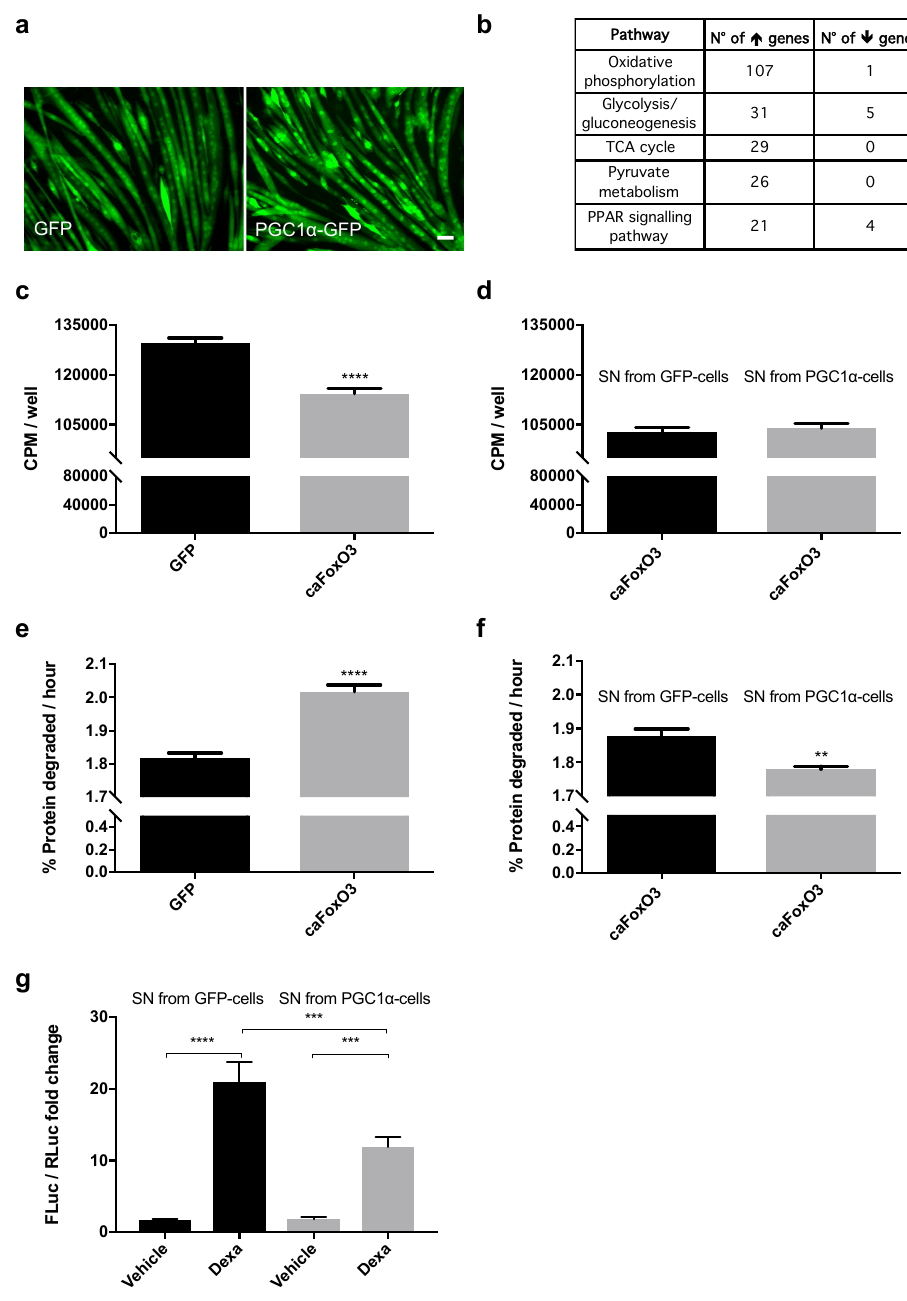
Figure 1. Peroxisome proliferator-activated receptor γ coactivator 1 α (PGC1 α )-overexpressing myotubes secrete some anti-catabolic factors. Representative fields of four-day di ff erentiated myotubes infected for 48 h with Green Fluorescent Protein (GFP) or PGC1 α -GFP-expressing myotubes are